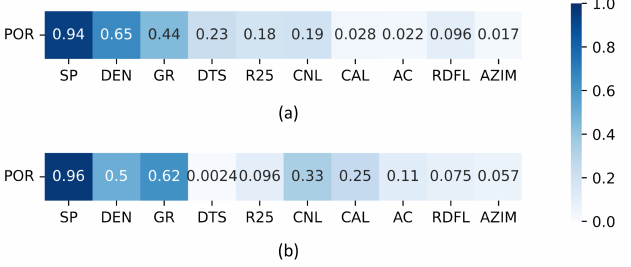
Figure 4. Heat map of correlation coefficients between 10 features and porosity. ( a ) Well Luo69. ( b ) Well